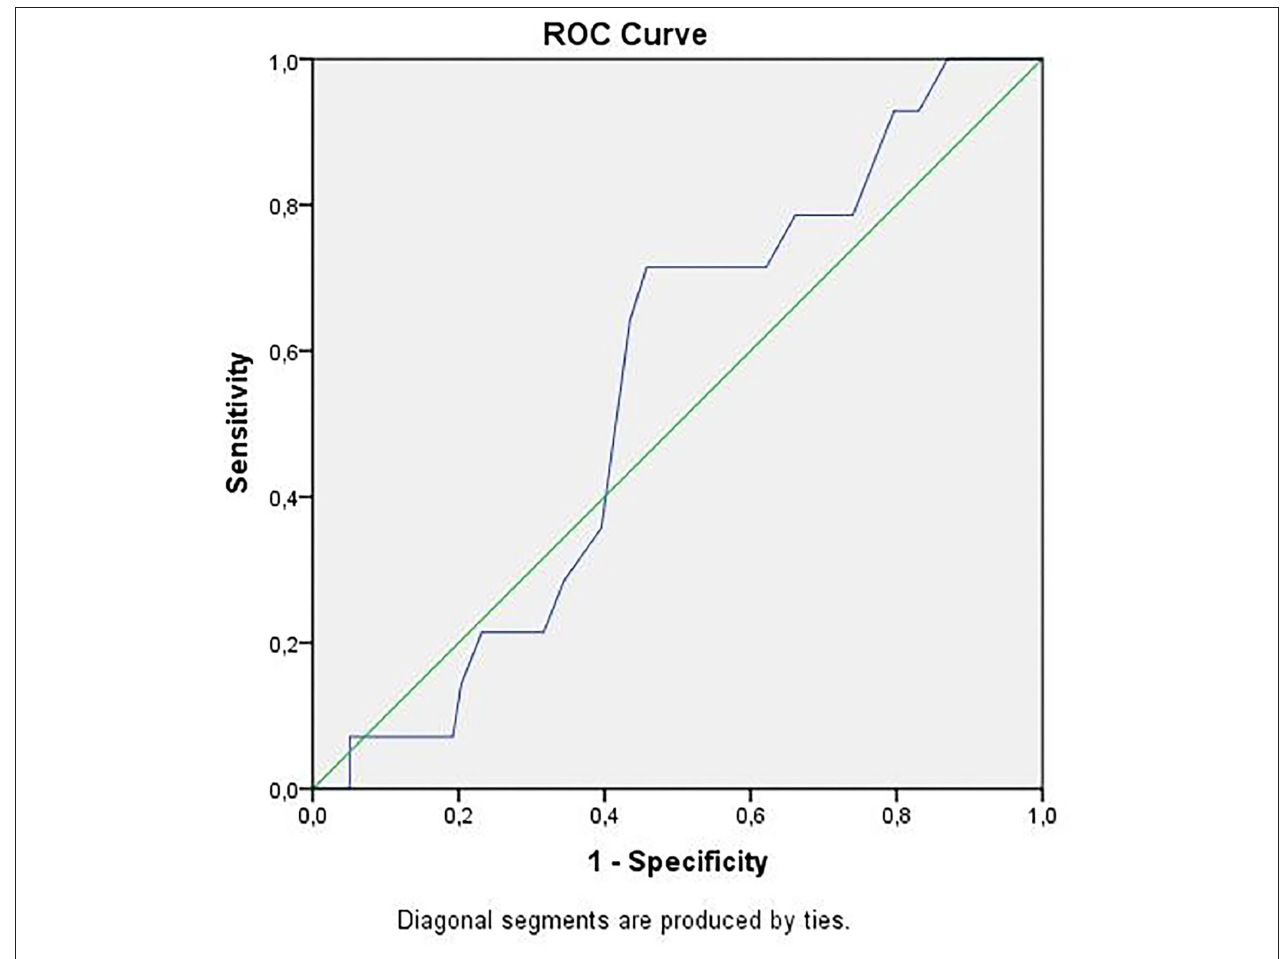
FIGURE 4 | ROC curve of mean platelet volume for intensive care unit transfer state when D-dimer < 1.0 mg/L. ROC, receiver operating